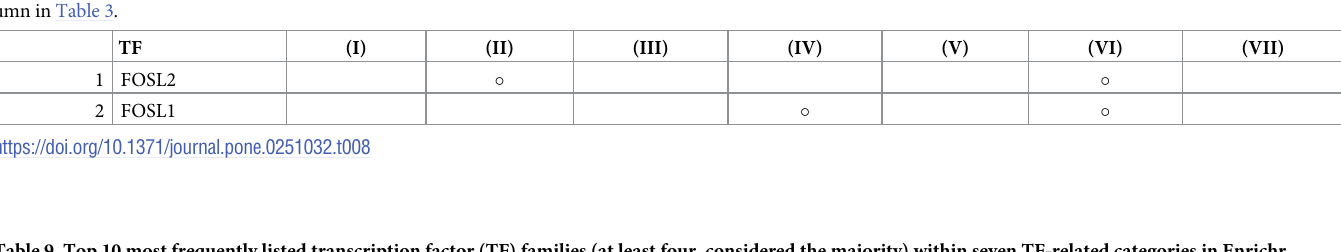
Table 9. Top 10 most frequently listed transcription factor (TF) families (at least four, considered the majority) within seven TF-related categories in Enrichr. Roman numerals correspond to the first column in Table 3.